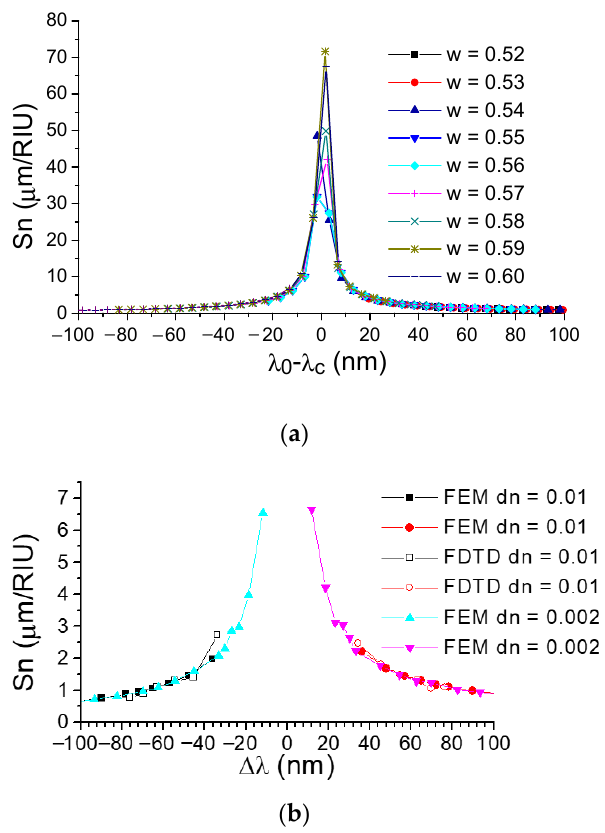
Figure 8. Dependence of the absolute value of the homogeneous sensitivity S n on the optical wavelength increment ∆ λ = λ − λ c for the collinear Bragg diffraction from the TE 0 mode to the TE 1 mode for the structure from Figure 1b when surrounded by distilled water with a small perturbation (dn = 0.002) of its refractive index. ( a ) Calculation under the EIM approximation for infinitive grating. ( b ) Calculation by the 3D FEM method for mode indexes (infinitive grating) and by the 3D FDTD method (compact grating with length of 172 μ m) for wavelength responses.